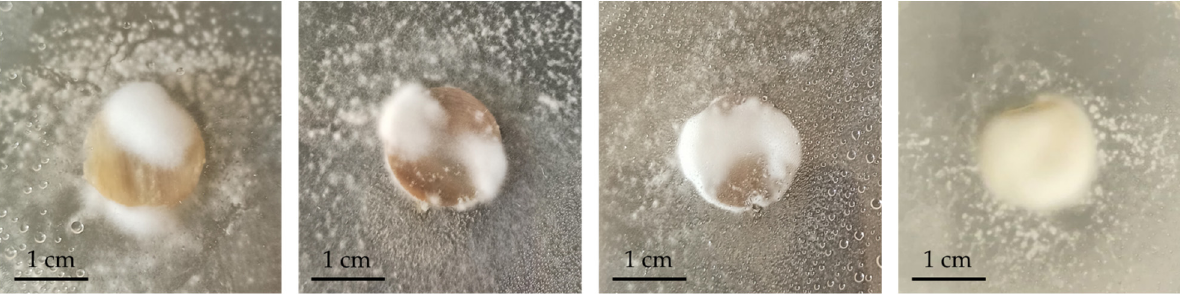
Figure 6. T. interdigitale 10326 growth on bovine membrane in WA at 10, 12, 15, and 27 days (from left to right).